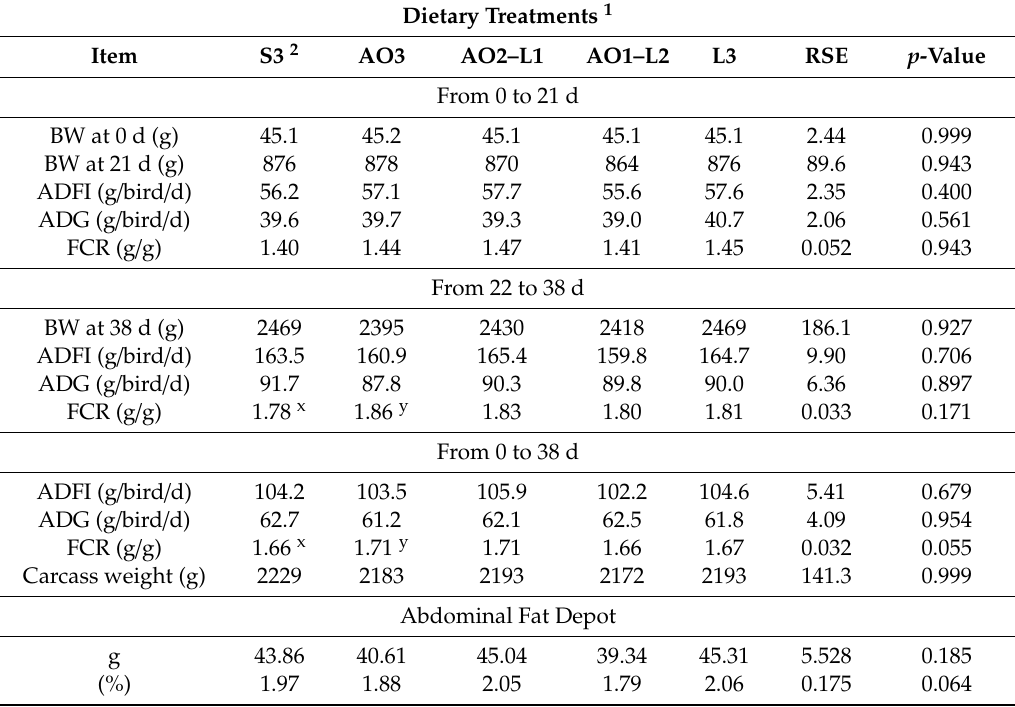
Table 6. Growth performance and abdominal fat pad deposition of broiler chickens according to di ff erent dietary added fats (Experiment 2). Dietary Treatments